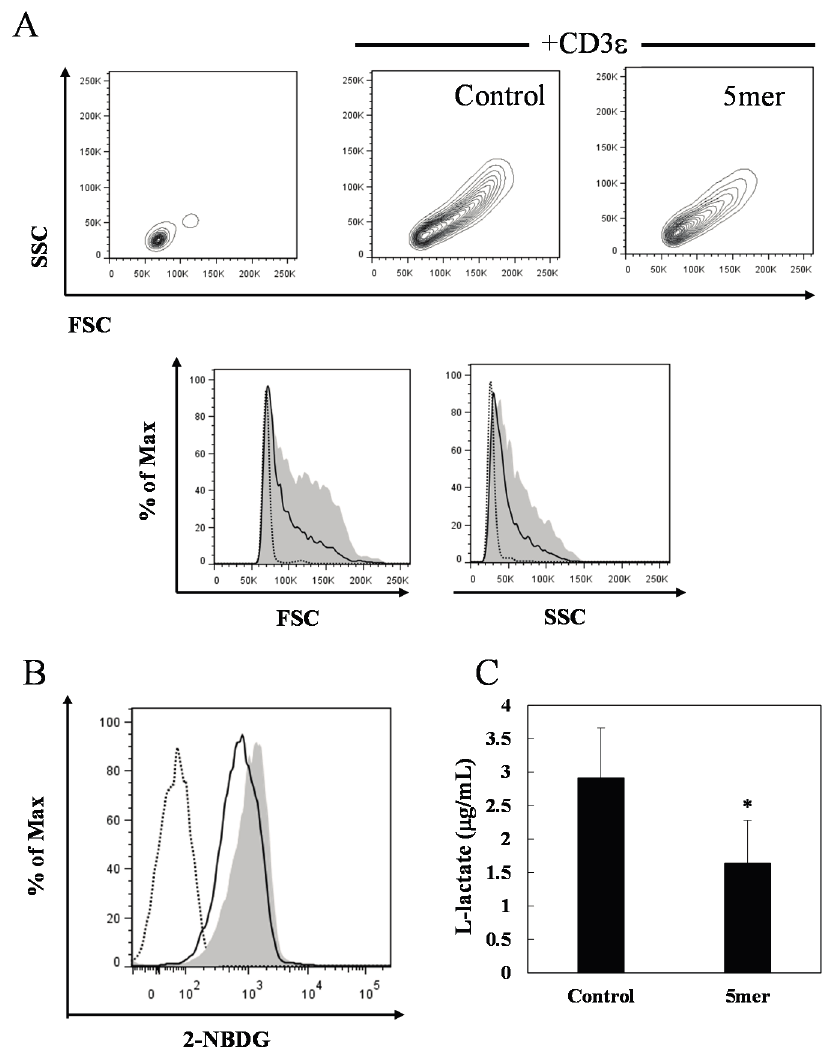
Figure 5. Effects of pentameric procyanidin on the glycolytic activities of activated CD4 + T cells. Cell growth ( A ), glucose uptake ( B ); and L -lactate production ( C ) of splenic CD4 + T cells stimulated with an anti-CD3 ε monoclonal antibody (mAb) in the presence of pentameric procyanidin (25 μ M) for 24 h. ( A ) The dotted line indicates the signal from cells that were not stimulated with the anti-CD3 ε mAb. The shaded plot and the black line represent the signals from cells cultured with 0 and 25 μ M of pentameric procyanidin, respectively; ( B ) The dotted line indicates the signal from cells incubated in the absence of 2-( N -[7-nitrobenz- 2-oxa-1,3-diazol-4-yl]amino)-2-deoxyglucose (2-NBDG). The shaded plot and the black line represent the signals from cells cultured with 0 and 25 μ M of pentameric procyanidin, respectively; ( C ) The data shown are the means ± SD from quintuplicate cultures. Statistical comparisons were performed using the Student’s t -test. Significance is relative to the negative control (* p < 0.05). FSC, forward scatter; SSC, side